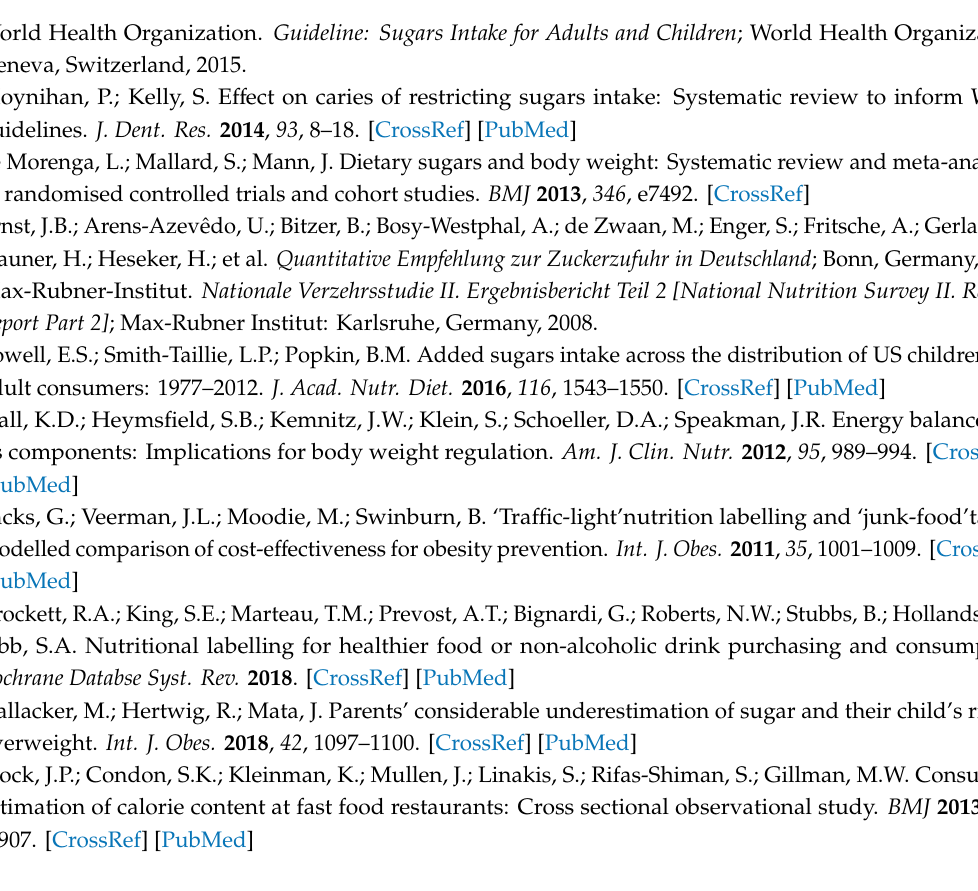
Figure S1. Food items used in the study, as depicted in the questionnaire. Top row, from left to right: quiche, sandwich, vegetable sticks and creamy yogurt-herb sauce. Bottom row, from left to right: chocolate mousse, fruit skewers, mu ffi n, Figure S2. Food items placed under the plastic sneeze guard, as seen by participations during the estimation task, Table S1. Correlations ( N ) between deviations in percent within estimation measures and with BMI, Table S2. Correlations ( N ) between deviations in percent, Table S3. Correlations ( N ) between expected / perceived accuracy and absolute deviation, Table S4. Comparison of deviation in percent for estimation measures between participants who were experienced and unexperienced with food journaling, Table S5. Comparison of deviation in percent for estimation measures between female and male